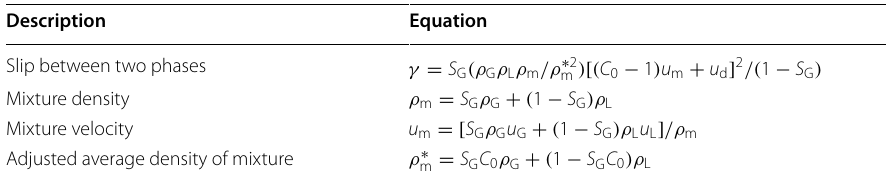
Table 3 Key drift–flux parameters in Eq. (13) Description